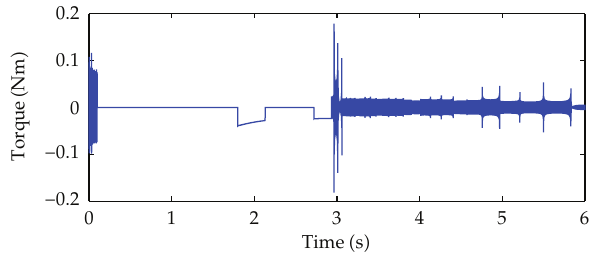
Figure 6: The input control u 2